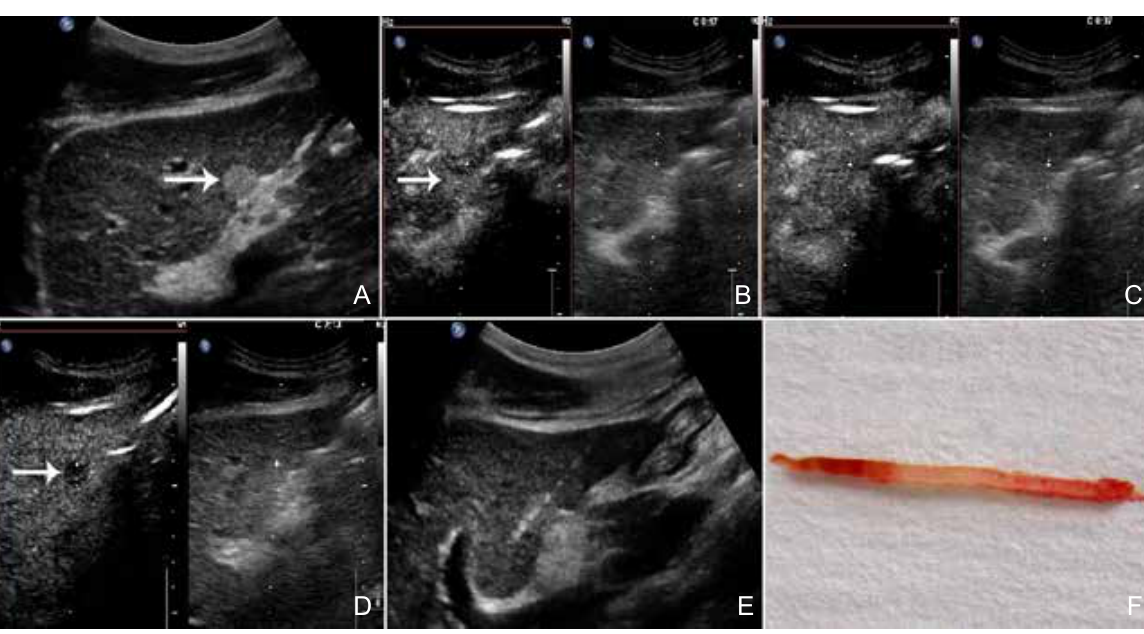
and white in middle segment, the middle segment was confirmed as well differentiated